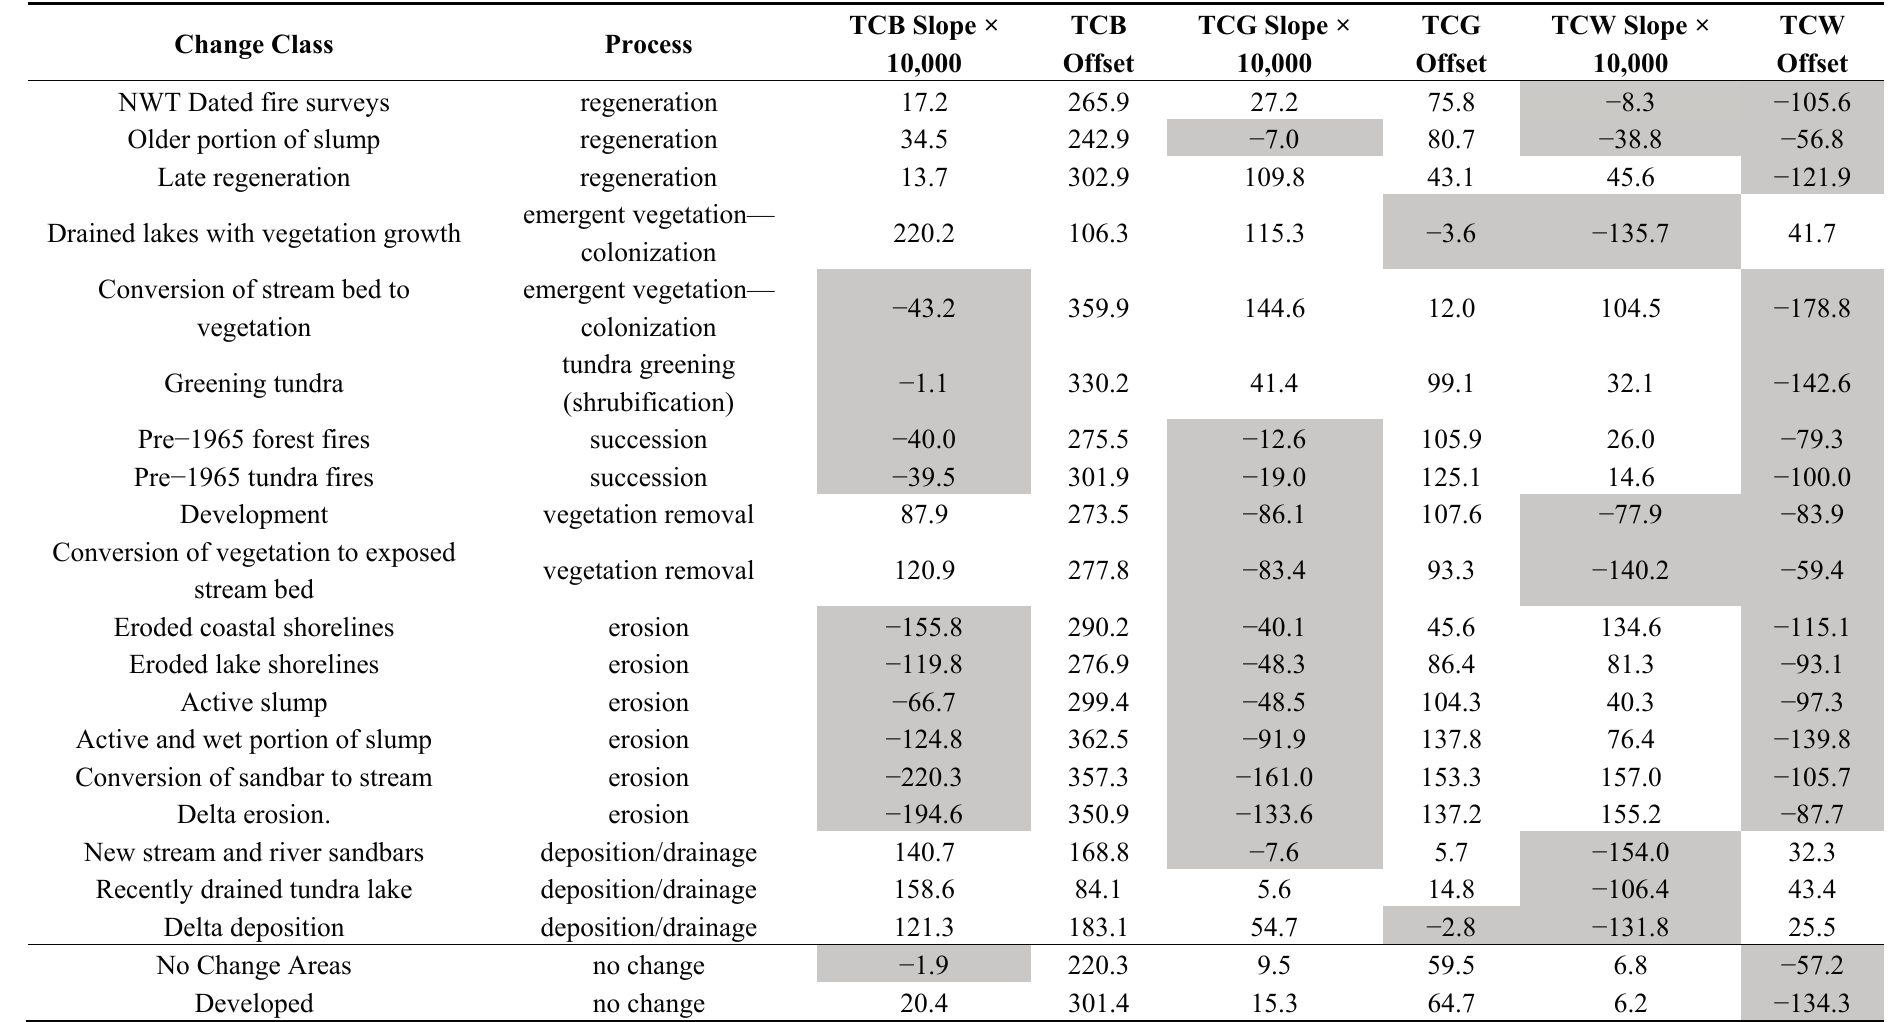
Table 5. Average robust Thiel-Sen regression coefficients by disturbance class sorted by change process. Negative coefficients are shaded to facilitate visualizing similarities between change classes within and between